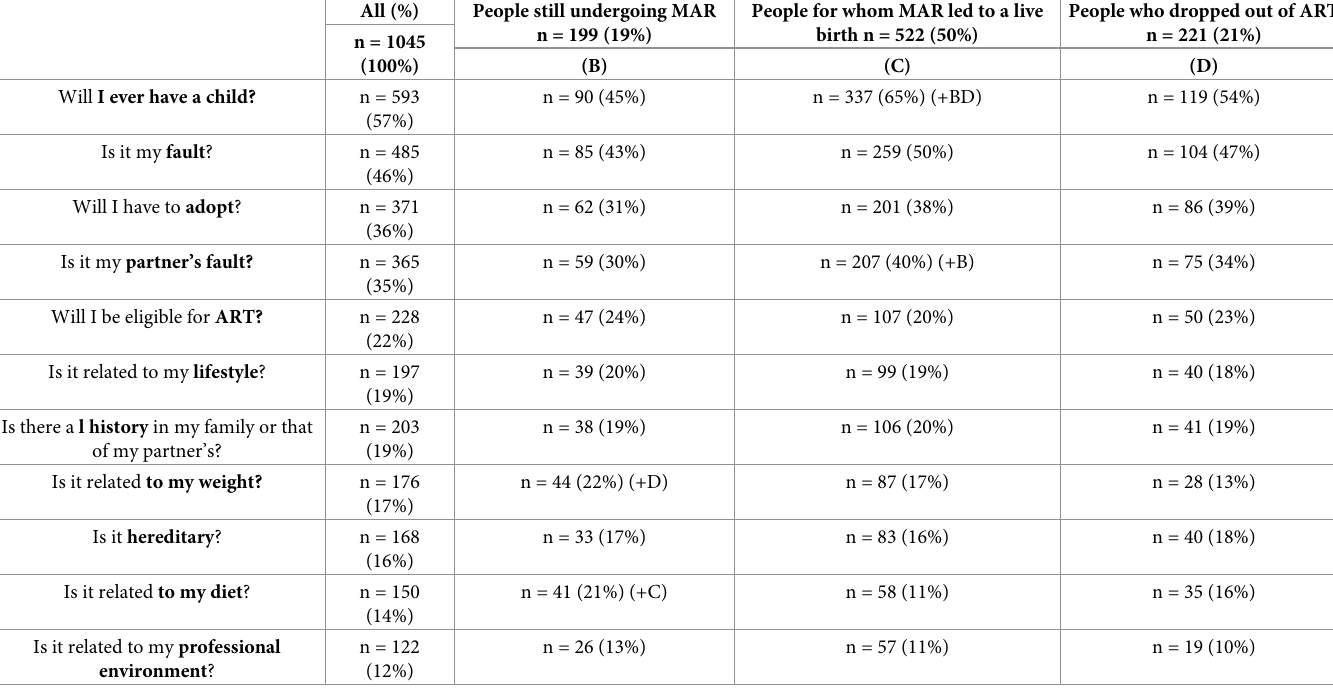
Table 2. A French national survey. MAR burden in the whole studied population (n = 1045) and in the three main subgroups of the respondents (n = 942). Responses to the question: “When you encountered first difficulties in having a child, what were all the questions you asked yourself at that